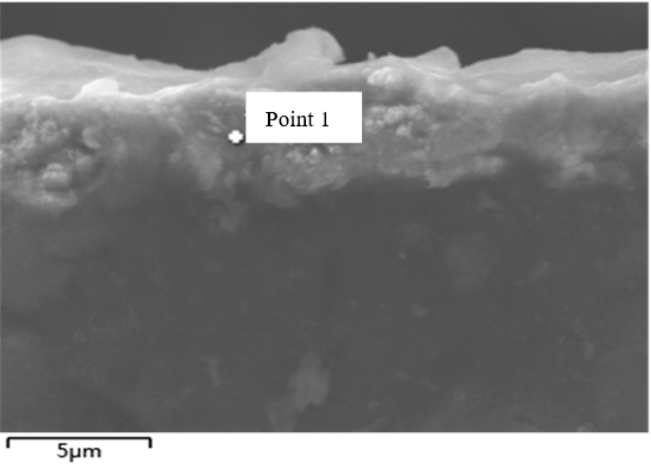
Figure 13. The section surface energy spectrum of DLC film. Table 4. Variable pressure ratio experimental operation conditions.